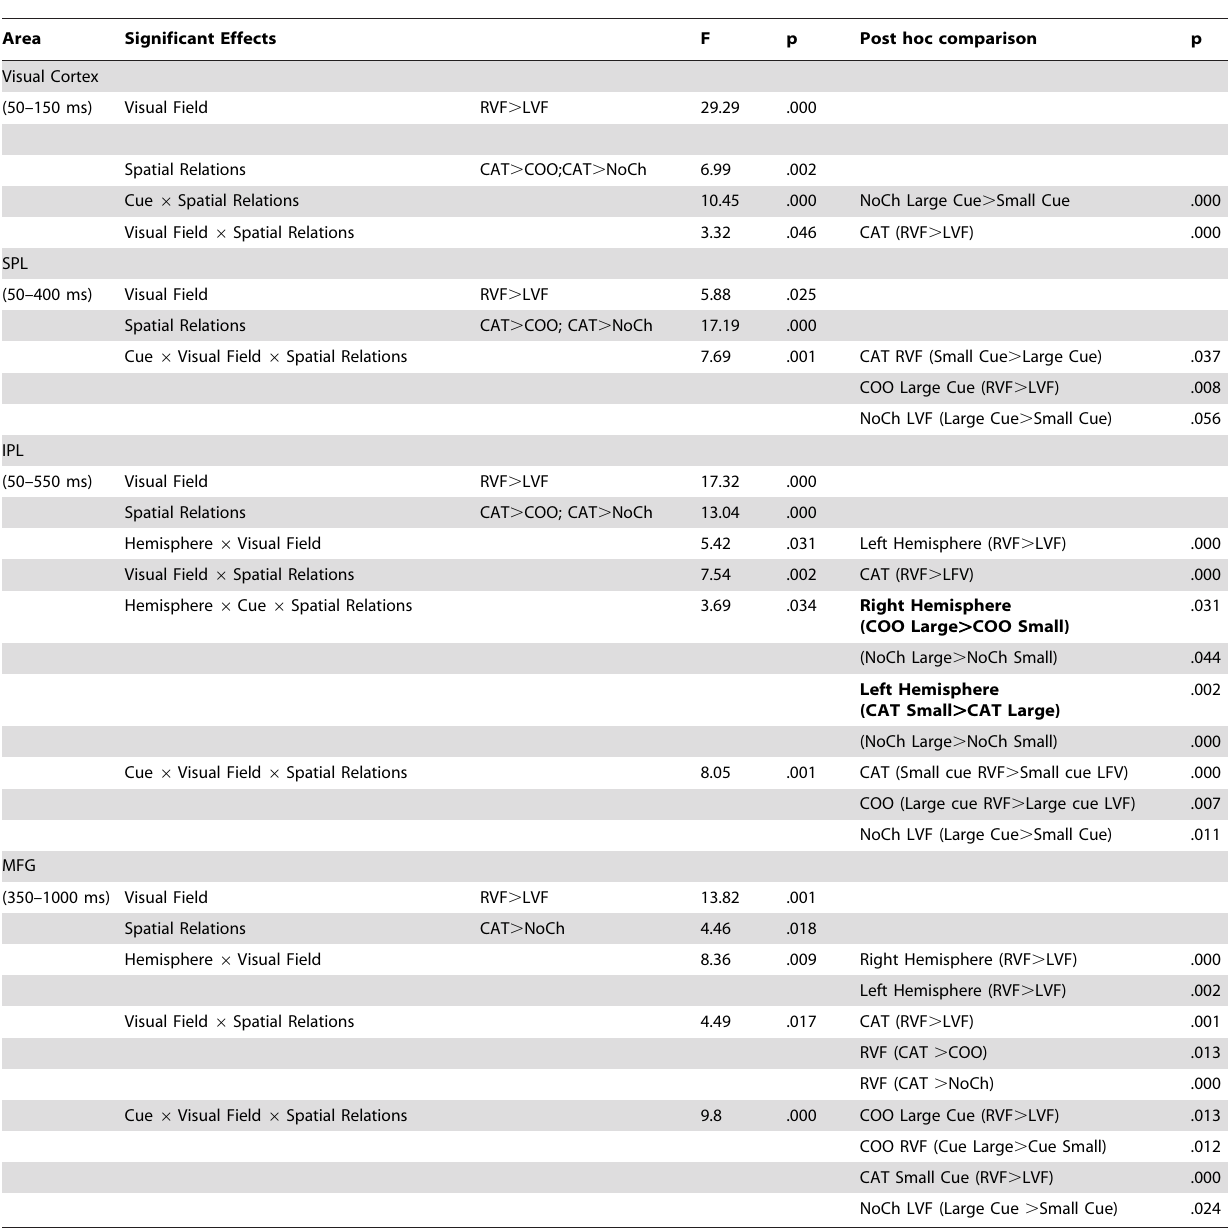
Table 2. Significant statistical results.